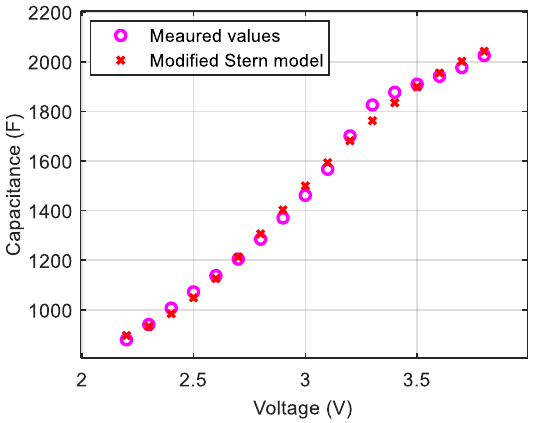
Figure 10. C(V) curve of a LiC that aged at 3.8 V and 70 °C for 17 months.